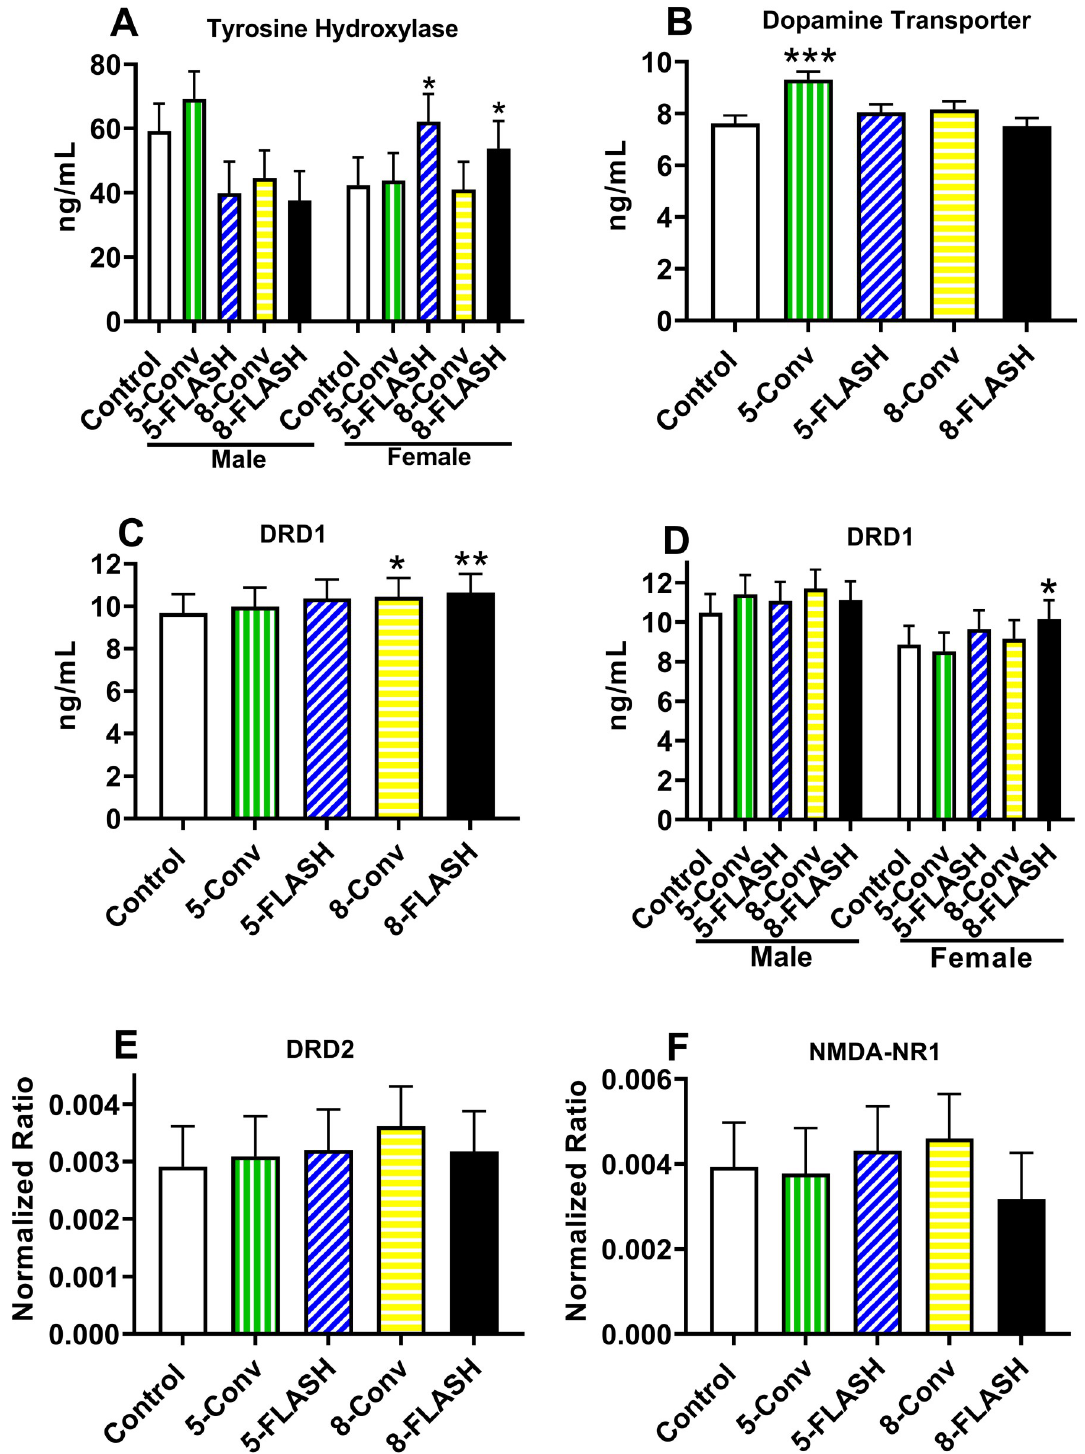
Fig 10. Physiological measures in irradiated and control rats in the neostriatum (A-E) and hippocampus (F). A. For TH there was no overall difference between irradiated groups and controls, but there was an exposure × sex interaction. There were no differences in males whereas the FLASH females, regardless of dose, had increased TH levels compared with control females. B . For DAT the 5-Conv group had increased levels of DAT compared with the controls. C. For DRD1 there was an increase in receptor levels for the groups that received 8 Gy, regardless of dose rate, compared with controls. D. There was an exposure × sex interaction. There were no